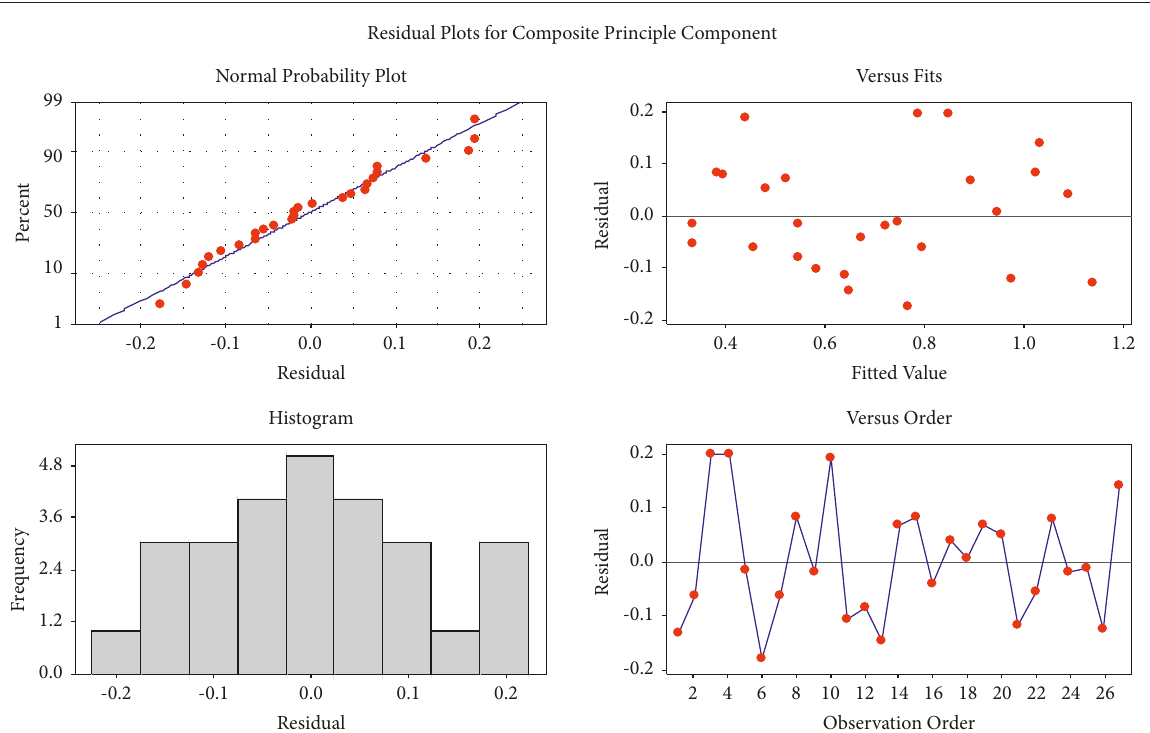
Figure 14: Residual plots for the composite principal